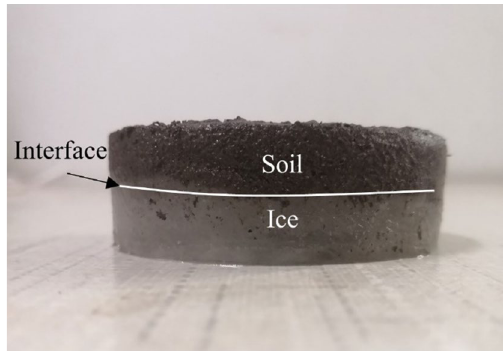
Figure 2. Photograph of soil-ice interface.